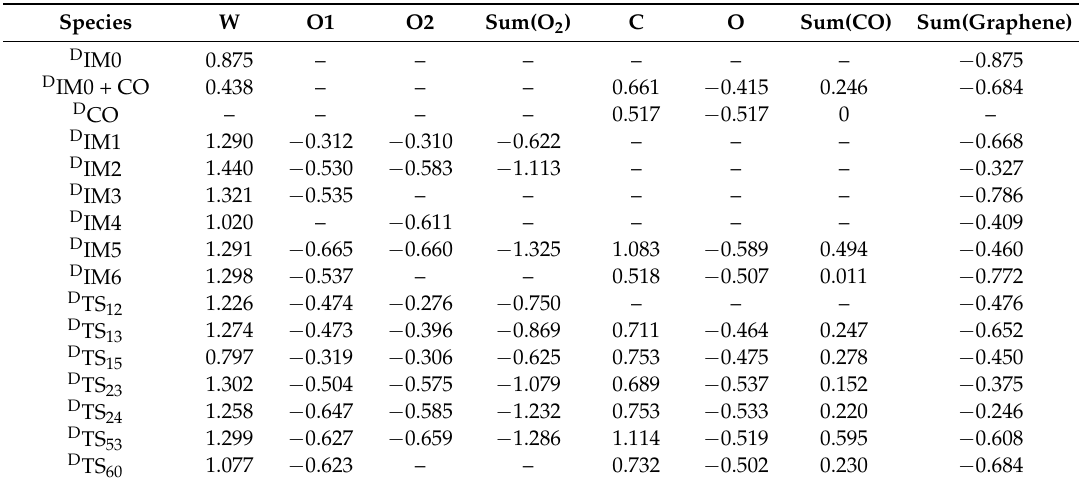
Table 2. Calculated NBO charge of different species over